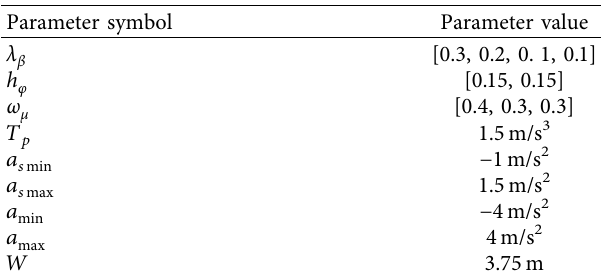
Table 2: Parameter